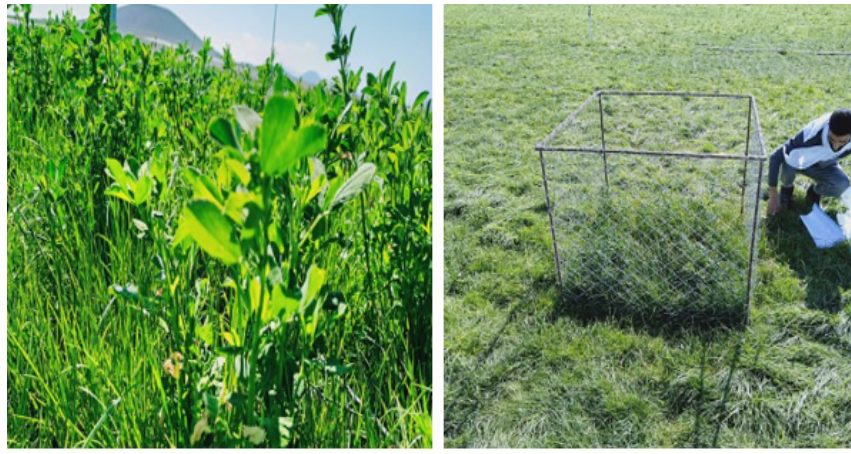
Figure 1. Sample collection from